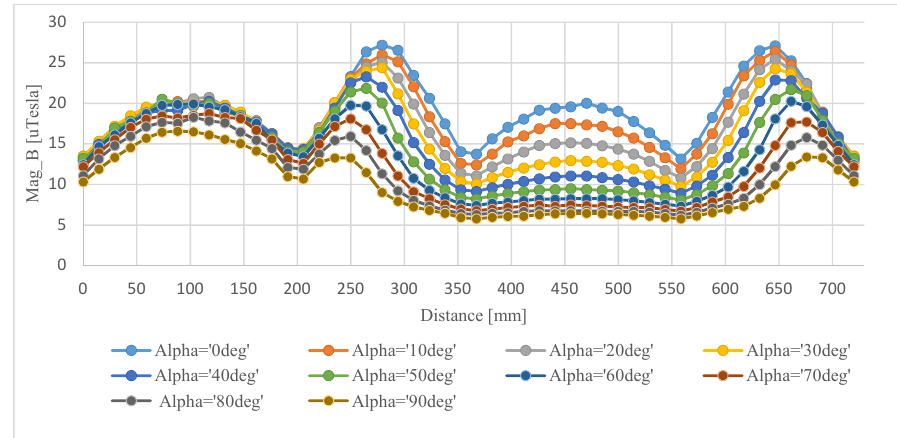
Figure 9. Magnetic-field density of chosen design of DL (30, 16) at different rotation angles of Rx coil. Electronics 2020 , 9 , x FOR PEER REVIEW